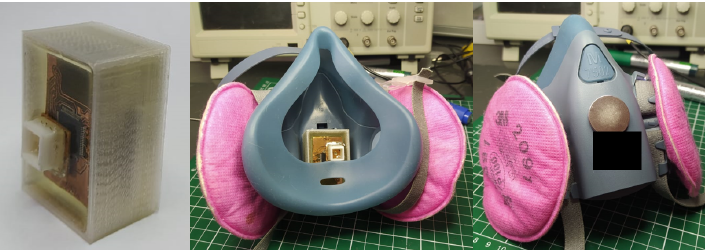
Figure 4. Implemented breathing monitoring embedded electronic device ( left ) inside a reusable respirator ( center ), where the positioning of the system is through an externally located magnet ( right ). The first image shows the embedded electronic device with epoxy